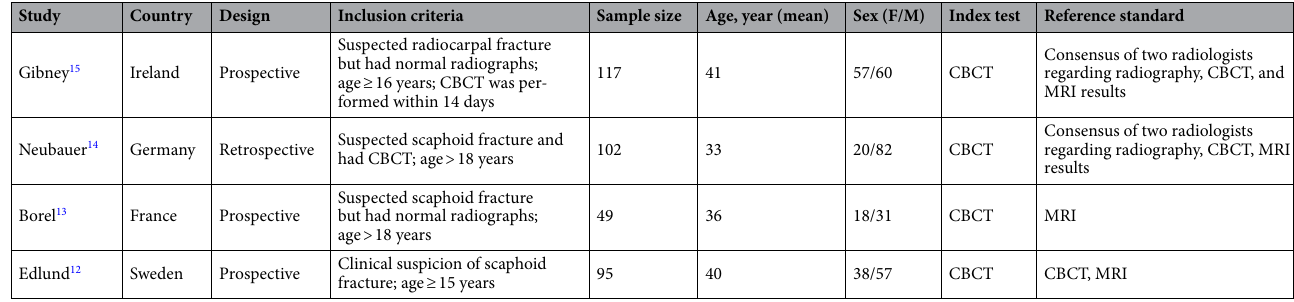
Table 1. Characteristics of included